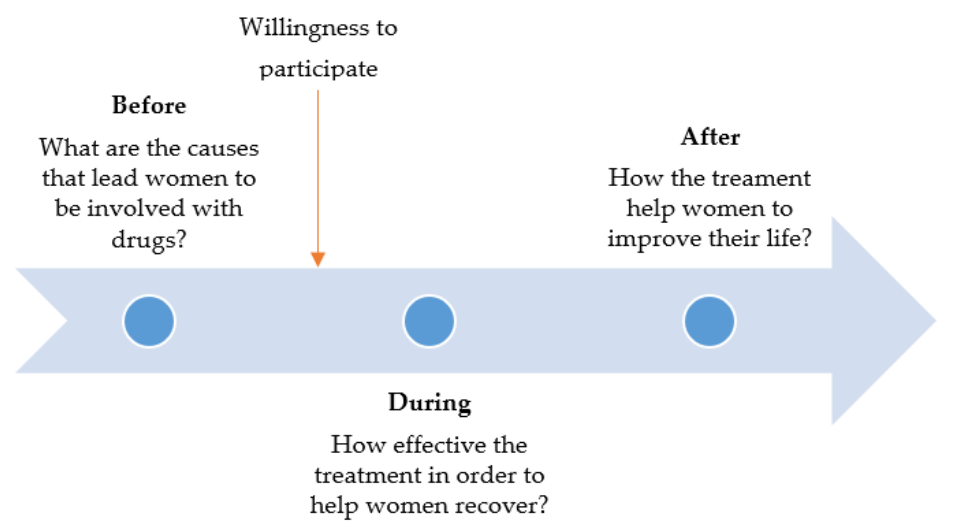
Figure 1. Representation Phases of women involvement in drug abuse and their journey to re- cover.